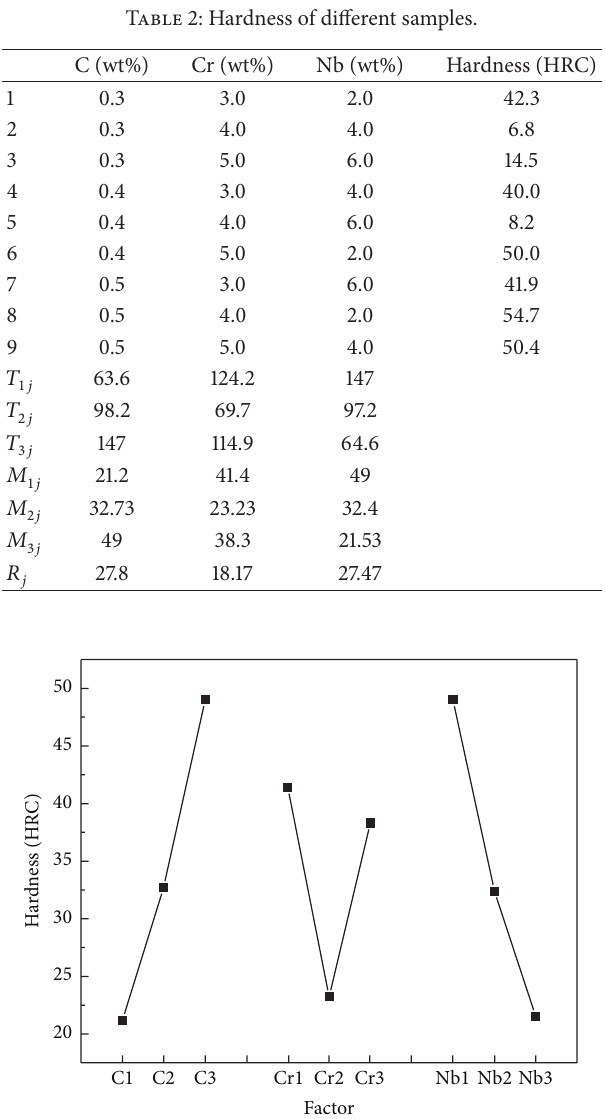
Figure 1: Relationship between hardness and